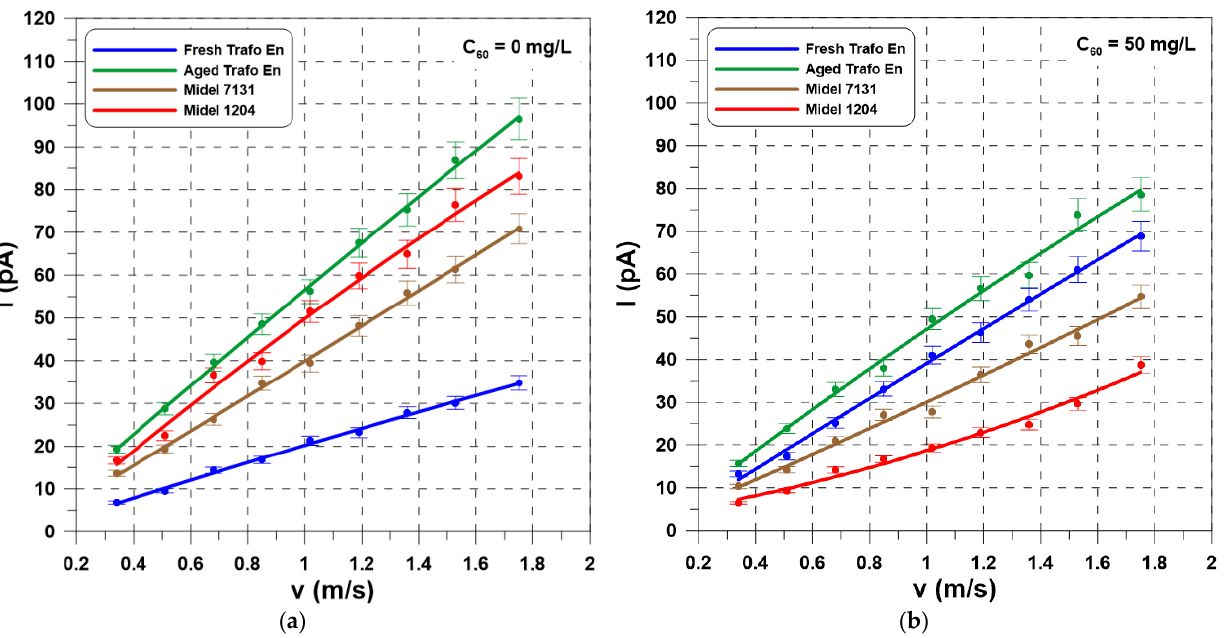
Figure 4. Electrification current versus flow velocity of ( a ) unmodified and ( b ) C 60 fullerene modified insulating liquids through an aluminum pipe ( T = 20 °C).